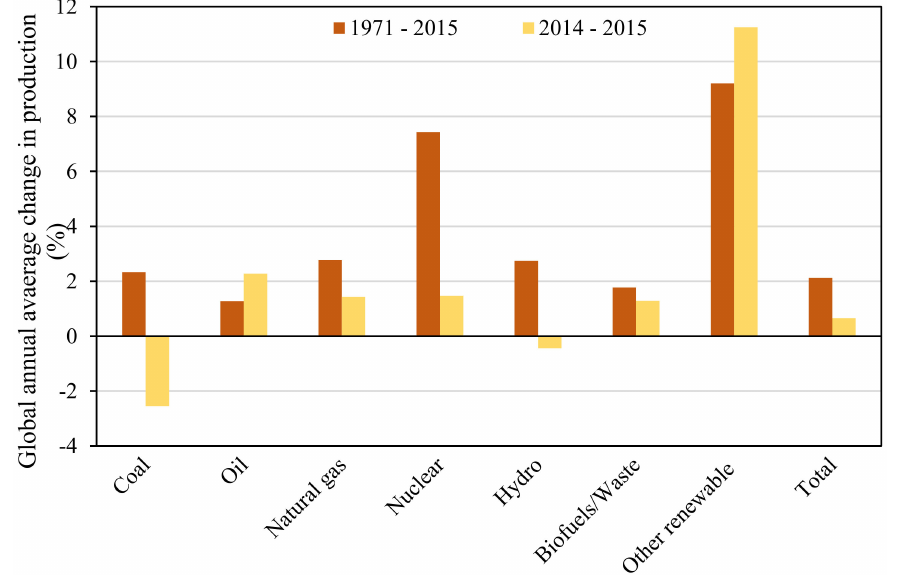
Figure 1. Global annual average change in energy production by fuel